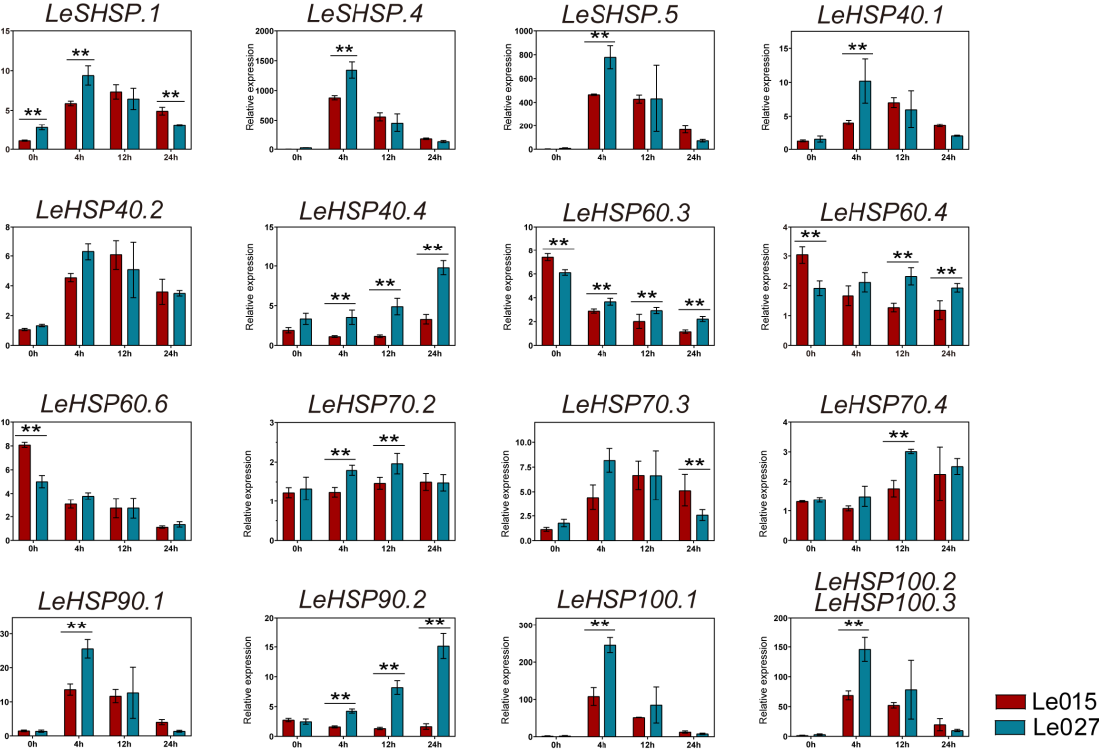
Figure 6. Expression profiles of LeHSP genes under heat stress in the strains of Le015 and Le027. Transcript level of different LeHSP genes (relative to geometric mean of LeTUB and LeUBI ) in response to heat stress in Le015 (red) and Le027 (blue). X-axes showed heat stress time. Y-axes indicated scales of relative expression level. One way ANOVA was used for statistical analysis. p -values are indicated as follows ** p < 0.01.